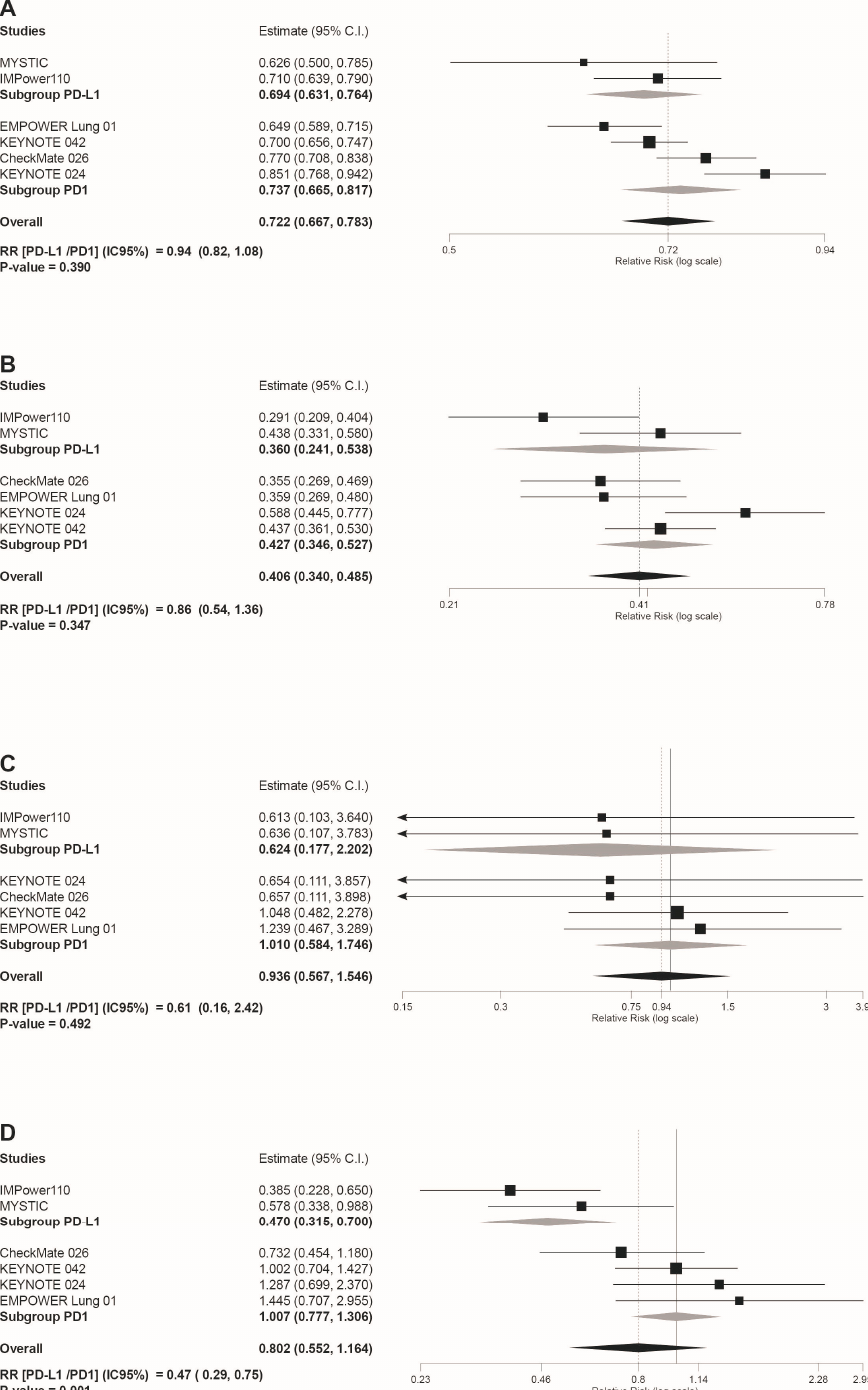
Figure 4. Forest plot of pooled risk ratios (RR) in the subgroup analysis((anti-PD-L1) versus (PD-1 inhibitors)) for: ( A ) any grade trAEs; ( B ) grade 3–4 trAEs ( C ) grade 5 trAEs; ( D ) AEs leading to discontinuation. Estimate, RR; CI, confidence interval. RR of ((anti-PD-L1) versus (PD1 inhibitors)) is shown at the bottom left. Treatments are ordered from top to bottom by lower to higher RR. Black squares indicate the weight of each RCT in the MA. The black rhomb indicates the weighted overall immunotherapy RR versus chemotherapy. Grey rhombs indicate, respectively, the weighted RR for anti-PD-1 immunotherapy subgroup compared to chemotherapy, and the weighted RR for anti-PD-L1 immunotherapy subgroup versus chemotherapy. The I 2 index values measuring the heterogeneity of effect-size estimates from the individual studies in MAs A to D correspond respectively to: (I 2 = 74.15%, p = 0.002); (I 2 = 61.78%, p = 0.023); (I 2 = 0%, p = 0.954); and (I 2 = 67.83%, p =